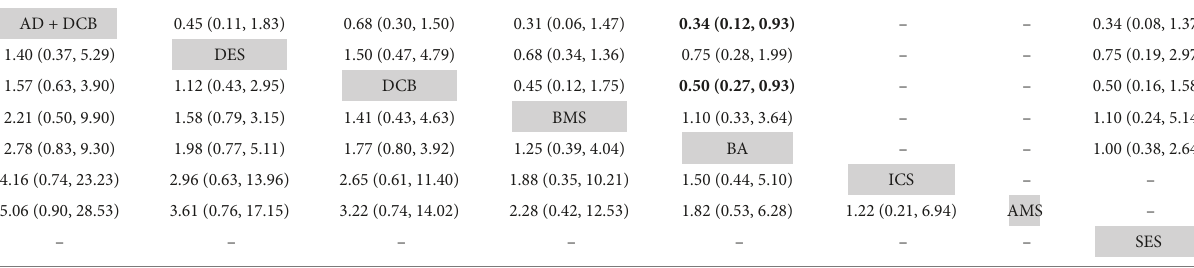
TABLE 2 Comparison results of network meta-analysis on 6-month (left) and 12-month (right) primary patency.